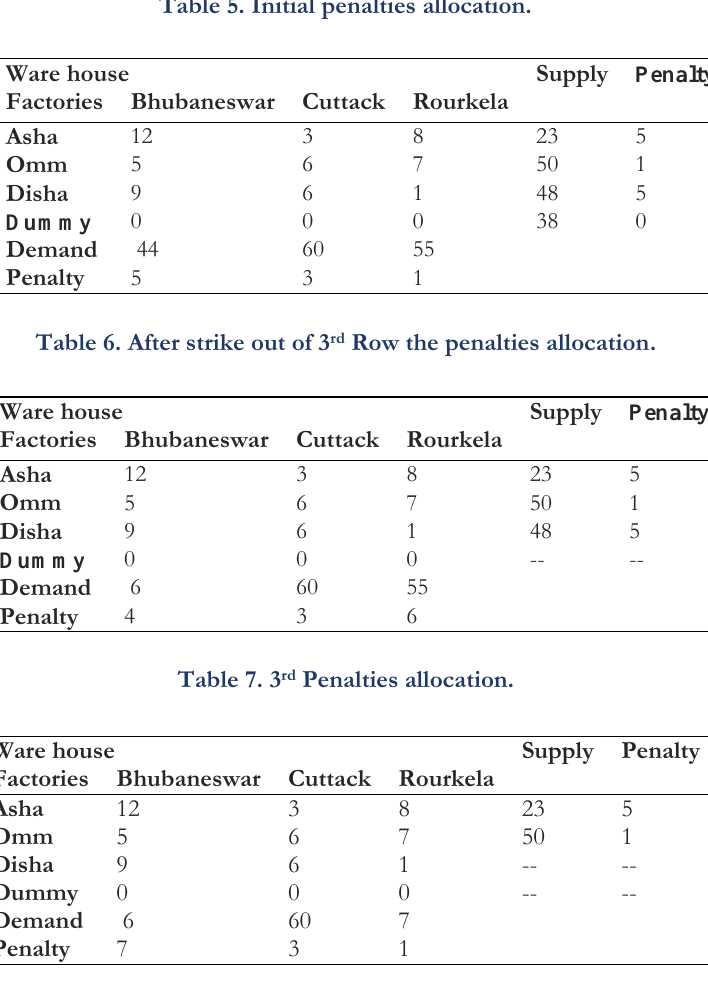
Table 5. Initial penalties allocation.